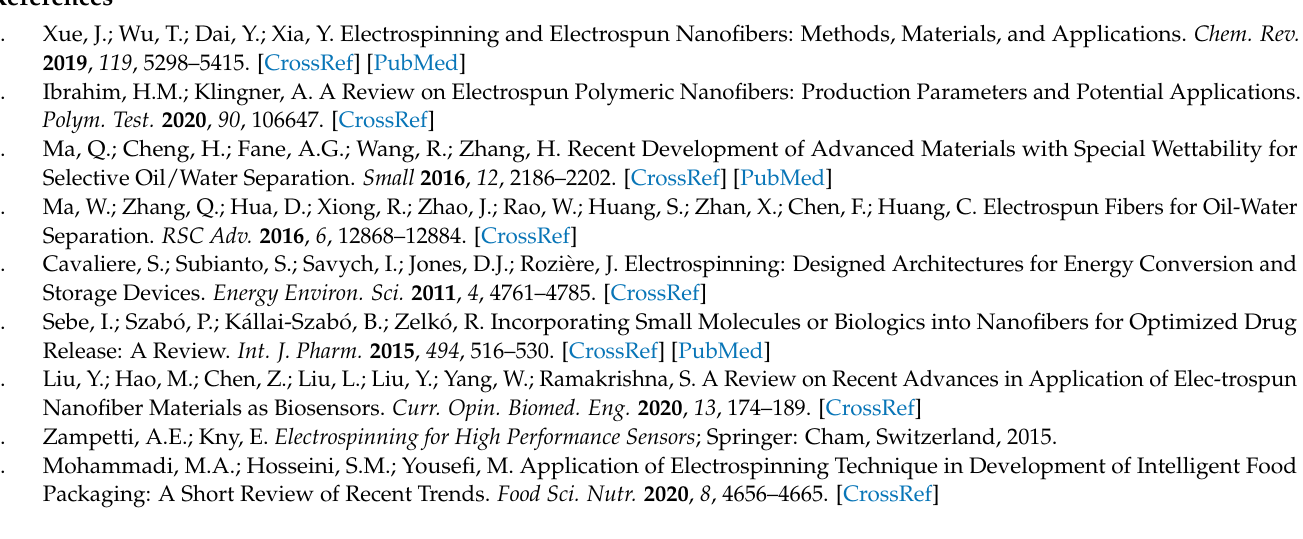
of the ATR-FTIR for the NFs mat 6 and 10. (b) Optical imagine of the mat 10 after modification and structure. (c) NFs size distribution, Figure S7: (a) Comparison of the ATR-FTIR for the NFs mat 6 and 11. (b) Optical imagine of the mat 11 after modification and structure. (c) NFs size distribution, Figure S8: (a) Comparison of the ATR-FTIR for the NFs mat 6 and 12. (b) Optical imagine of the mat 12 after modification and structure. (c) SEM of the polymeric mat 12, scale bars correspond to 10 µ m, Figure S9: (a) Comparison of the ATR-FTIR for the NFs mat 6 and 13. (b) Optical imagine of the mat 13 after modification and structure. (c) SEM of the polymeric mat 13, scale bars correspond to10 µ m, Figure S10: (a) Comparison of the ATR-FTIR for the NFs mat 6 and 14. (b) Optical imagine of the mat 14 after modification and structure. (c) SEM of the polymeric mat 14, scale bars correspond to 10 µ m (d) NFs size distribution, Figure S11: Comparison of color changing of the polymer blend PVP/TS-PIL 6 obtained by (a) casting or by (b) electrospinning in presence of the NH 3 vapor, Figure S14: Spectrum of polymer 6. (a) 1 H NMR spectra in D 2 O and (b) 13 C NMR Spectra in D 2 O, Table S1: Electrospinning parameters used to fabricate NFs mats., Table S1: Solubility evaluation of the NFs mat obtained from PVP/TS-PIL 6, Video S1: Colorimetric changes of NFm-6 with butylamine, Video S2: Colorimetric changes of NFm-6 with different amines, Video S3: Colorimetric changes of NFm-6 with